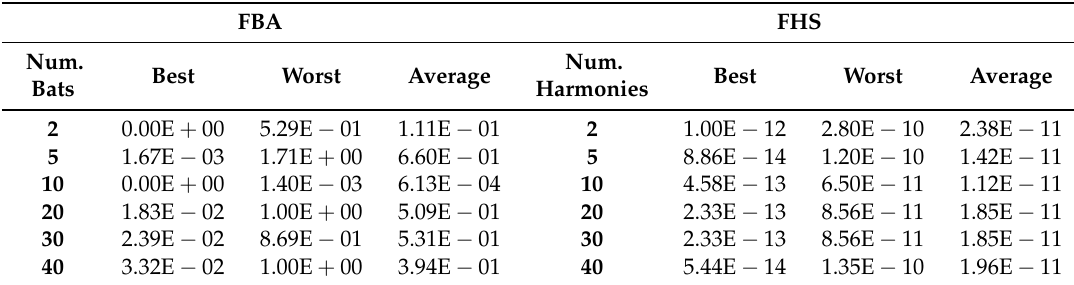
Table 15. Experiment results obtained for the Rosenbrock function with the FBA and FHS algorithms. FBA FHS